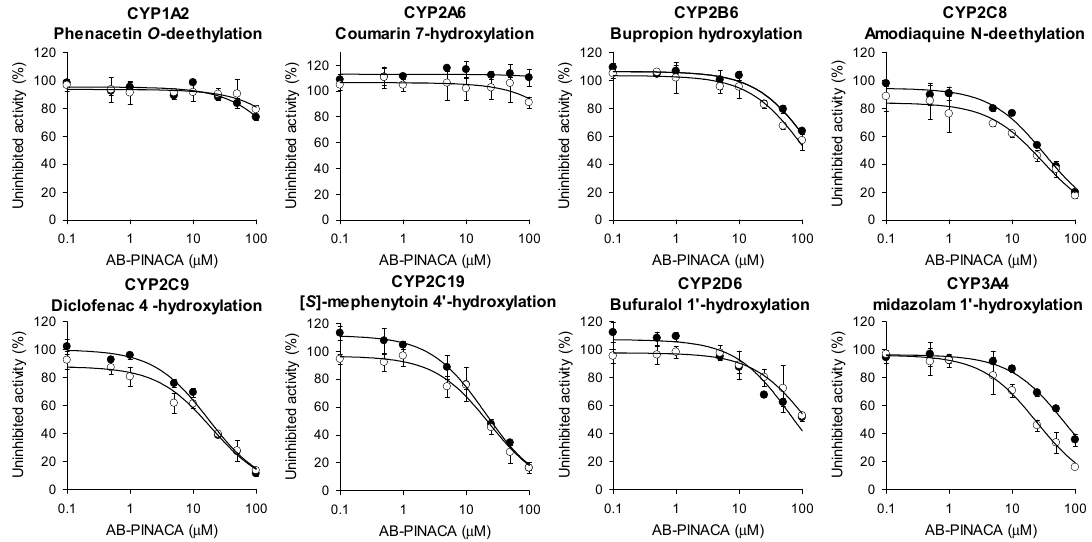
Figure 1. Inhibitory effects of AB-PINACA on metabolic activities of CYP1A2, CYP2A6, CYP2B6, CYP2C8, CYP2C9, CYP2C19, CYP2D6, and CYP3A4 in ultrapooled human liver microsomes with ( ) and without ( ) 30-min preincubation with NADPH at 37 ° C. The cocktail CYP probes consist of set A (50 µM phenacetin, 2.5 µM coumarin, 2.0 µM amodiaquine, 10 µM diclofenac, 100 µM [ S ]- mephenytoin, 5.0 µM bufuralol, and 2.5 µM midazolam) and set B (50 µM bupropion). Data are means ± SD ( n = 3).